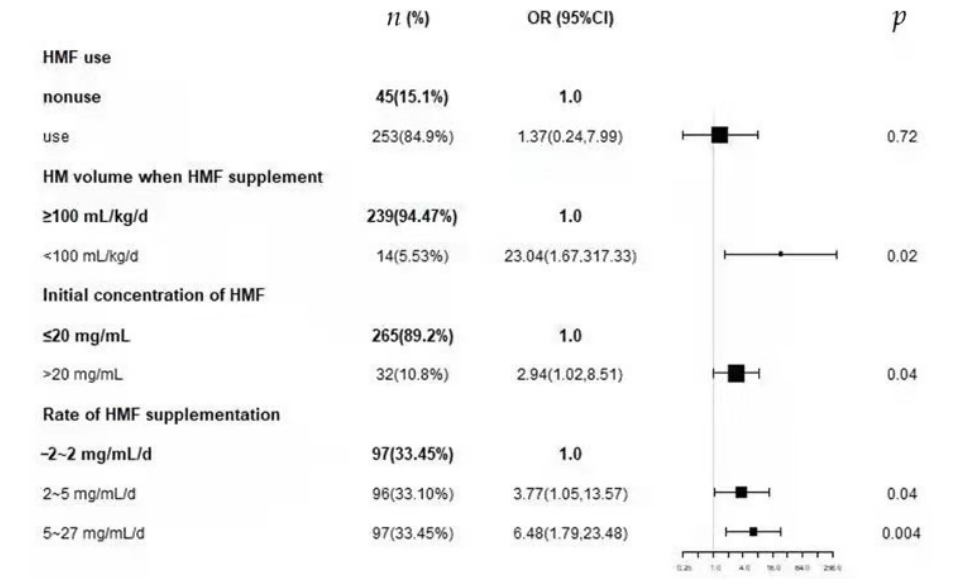
Figure 2. Forest plots for multivariate logistic regressions of the use of HMF on FI. FI, feeding intolerance; HM, human milk; HMF, human milk fortifier. Results on the right side reflect an increase in FI.